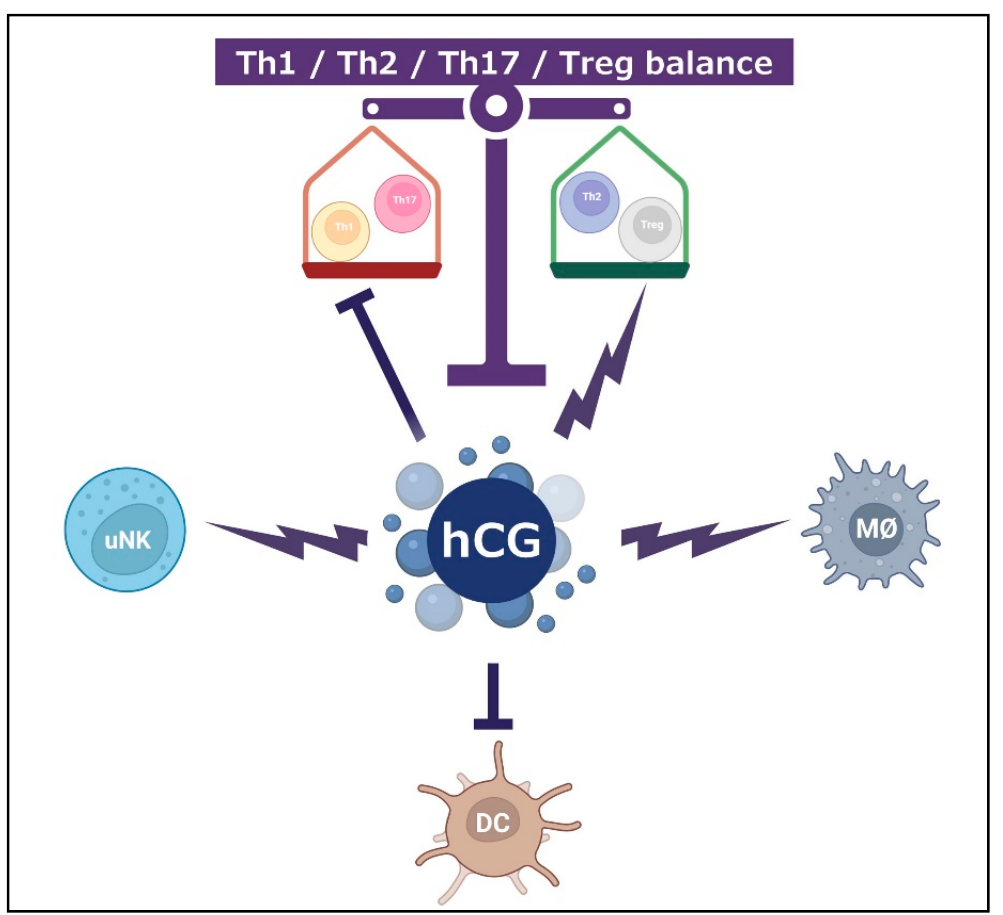
Figure 3. hCG and its immunotolerance effects through multiple cell types. hCG is acting positively on uNK, macrophages (M Ø ), and Th2/Treg. hCG is acting negatively on DC, and Th1/Th17.